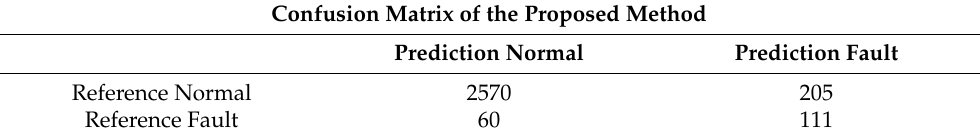
Table 4. The results of the validation set.